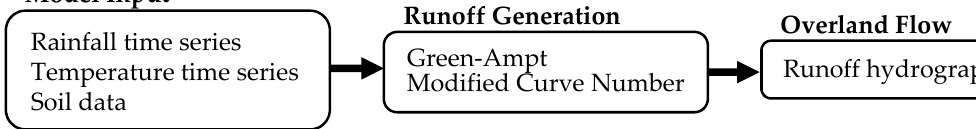
Figure 1. Conceptual framework for the hydrology module.